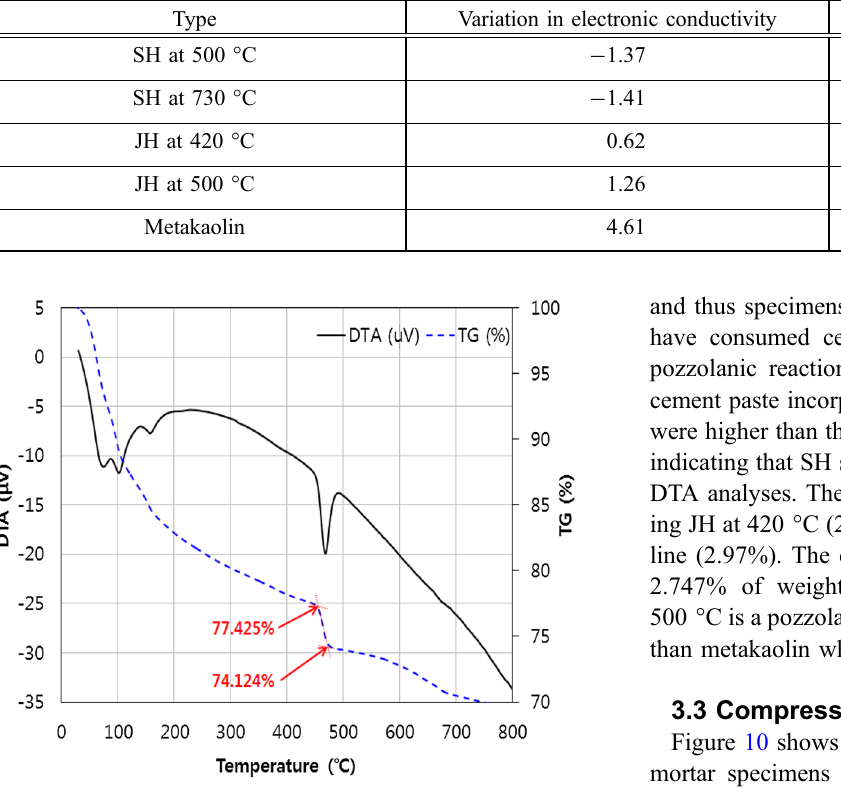
Fig. 8 TG/DTA analysis of 28 day old cement paste: plain (w/ b = 0.5).